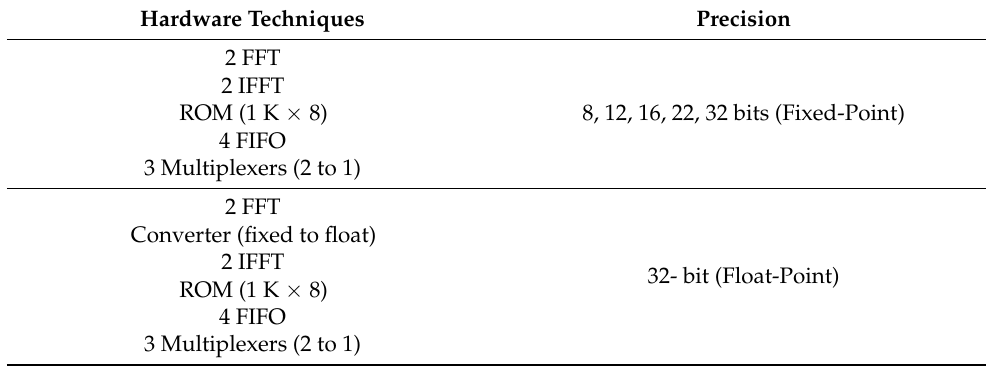
Table 2. Hardware techniques and precision types .